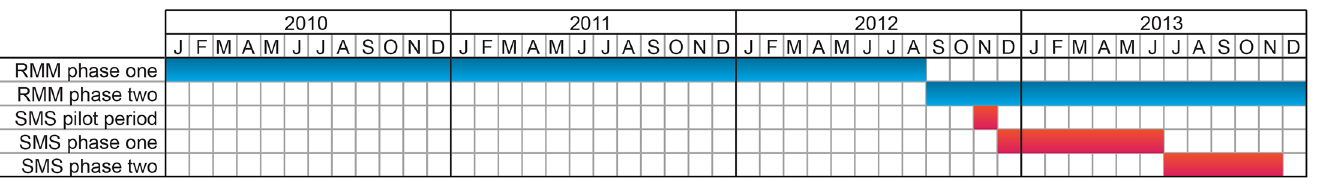
Fig 1. SMS timeline. Timeline of RMM project and SMS implementation from January 2010 through December 2013.